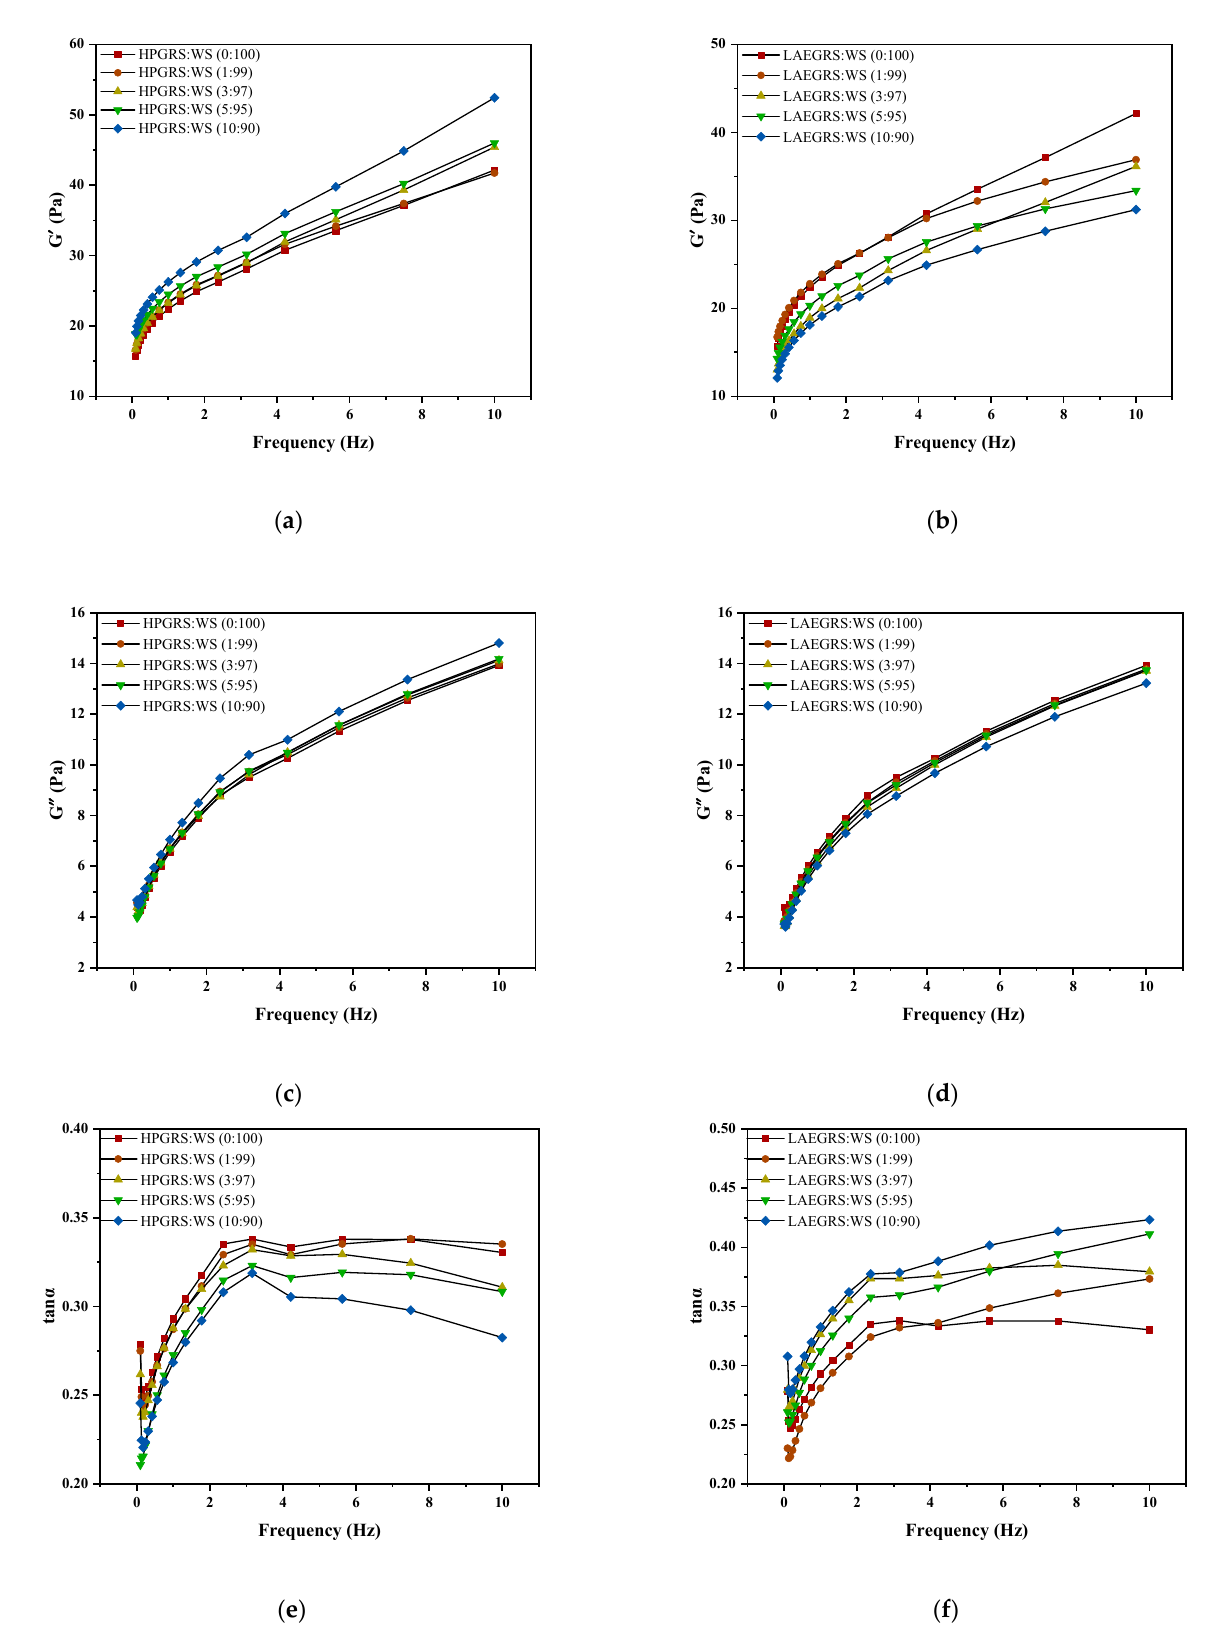
Figure 2. The revision is as follows: The G ′ ( a , b ), G ″ ( c ,d), and tan α ( e , f ) curves of different propor- tions of HPGRS and LAEGRS (0%, 1%, 3%, 5%, and 10%) blended with WS respectively.